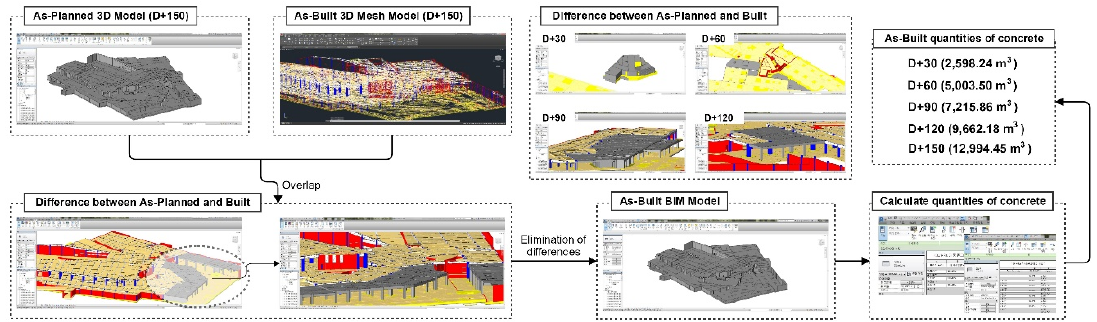
Figure 8. Example of the quantity calculation of the BIM-based as-built concrete.